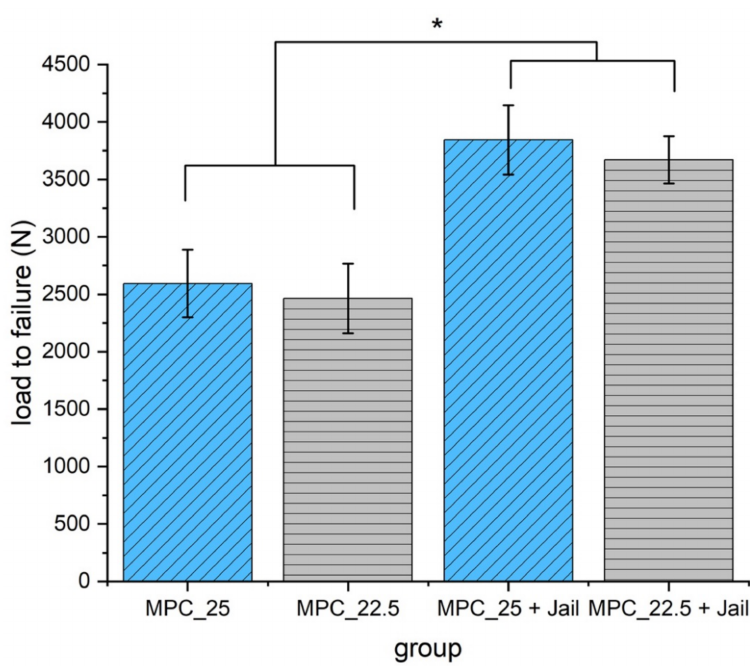
Figure 14. Load to failure of the reduced and fixed fractures with MPC and MPC plus screws in the jail technique. Groups with screws showed significantly higher load to failure values when compared to the groups without screws ( p < 0.05, marked with an asterisk *). No significant difference was found within the groups with a bone substitute, only (MPC_25 vs. MPC_22.5, p = 0.387), and within the groups with screws (MPC_25 + Jail vs. MPC_22.5 + Jail, p = 0.297).